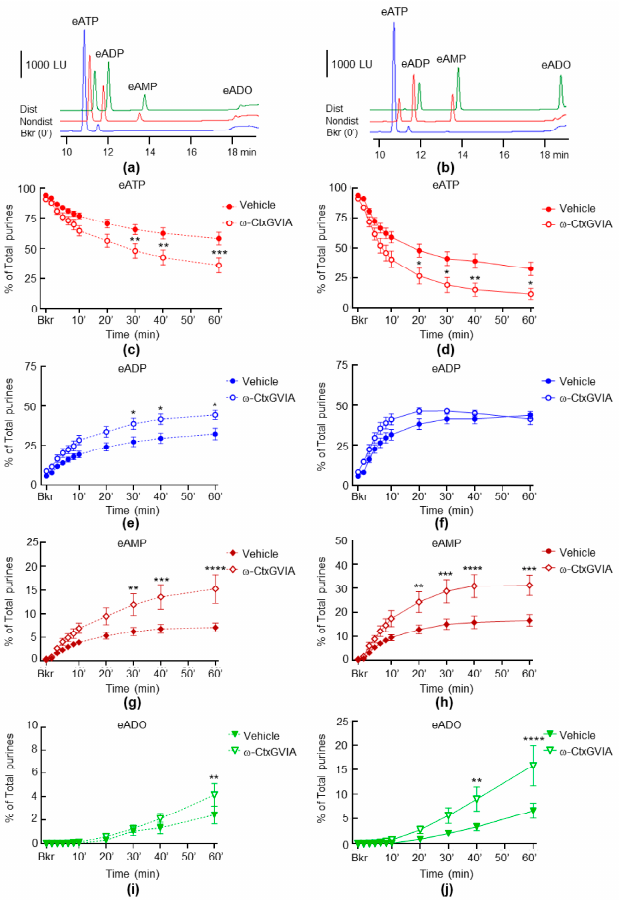
Figure 3. E ff ects of ω -Ctx GVIA on the hydrolysis of eATP by s-ENTDs released in cELS of non- distended and distended detrusor-free bladder preparations. Original chromatograms of eATP in beaker (Bkr, blue, 0 ′ , no enzyme present) and at 60 min of enzymatic reaction in cELS of non- distended (Nondist, red) and distended (Dist, green) bladder preparations treated with vehicle ( a ) or ω -Ctx GVIA ( b ). LU, luminescence units. Summarized data showing changes in eATP, eADP, eAMP and eADO in the presence of vehicle (KBS, n = 8) and ω -CtxGVIA 0.1 µM ( n = 6) in nondistended ( c , e , g , i ) and distended ( d , f , h , j ) bladder preparations; n , number of bladder prepara- tions. eATP, eADP, eAMP and eADO are presented as percentages of total purines (eATP + eADP + eAMP + eADO) present in reaction solutions. Asterisks denote signi fi cant di ff erence from vehicle controls. * p < 0.05, ** p < 0.01, *** p < 0.001, **** p < 0.0001. Two-way ANOVA with Sidak’s multiple comparisons tests.